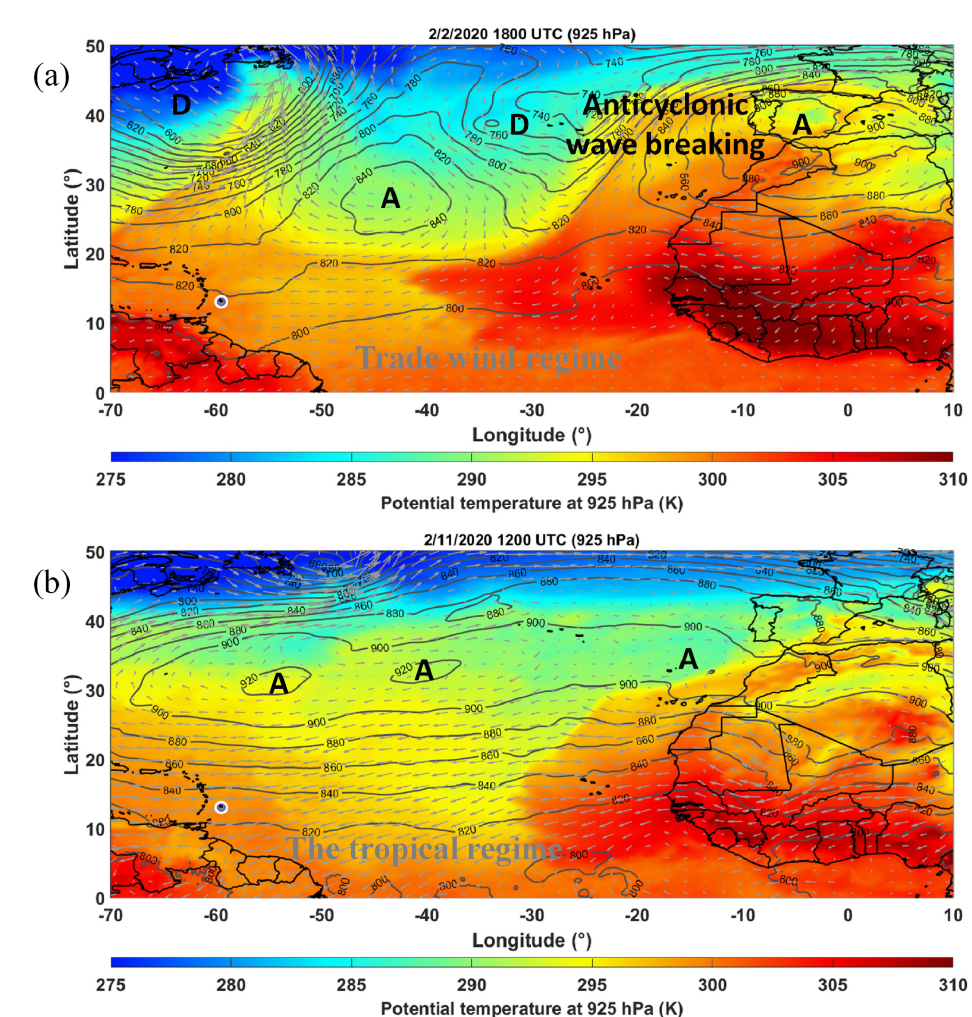
Figure 14. Equivalent potential temperature at 925hPa on (a) 2 February at 18:00UTC, example of the trade wind regime with an anticy- clonic Rossby wave breaking; and (b) 11 February 12:00UTC, example of the tropical regime. The anticyclones (A) and depressions (D) are